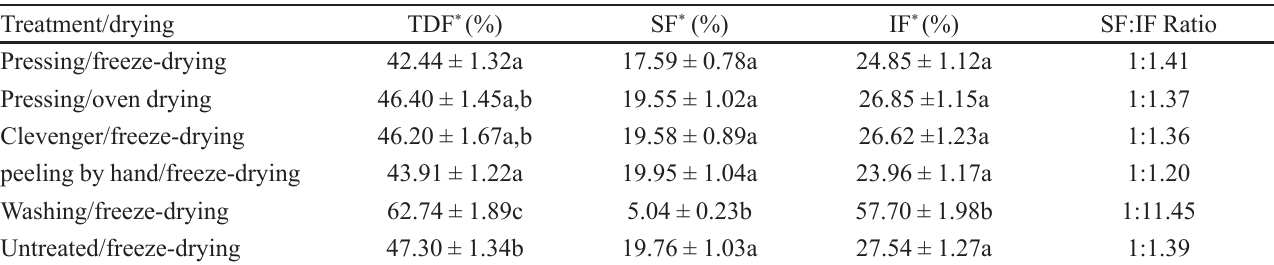
TABLE IV - Percentage composition of total dietary fiber (TDF), soluble (SF) and insoluble (IF) fibers from different samples, obtained by triplicate